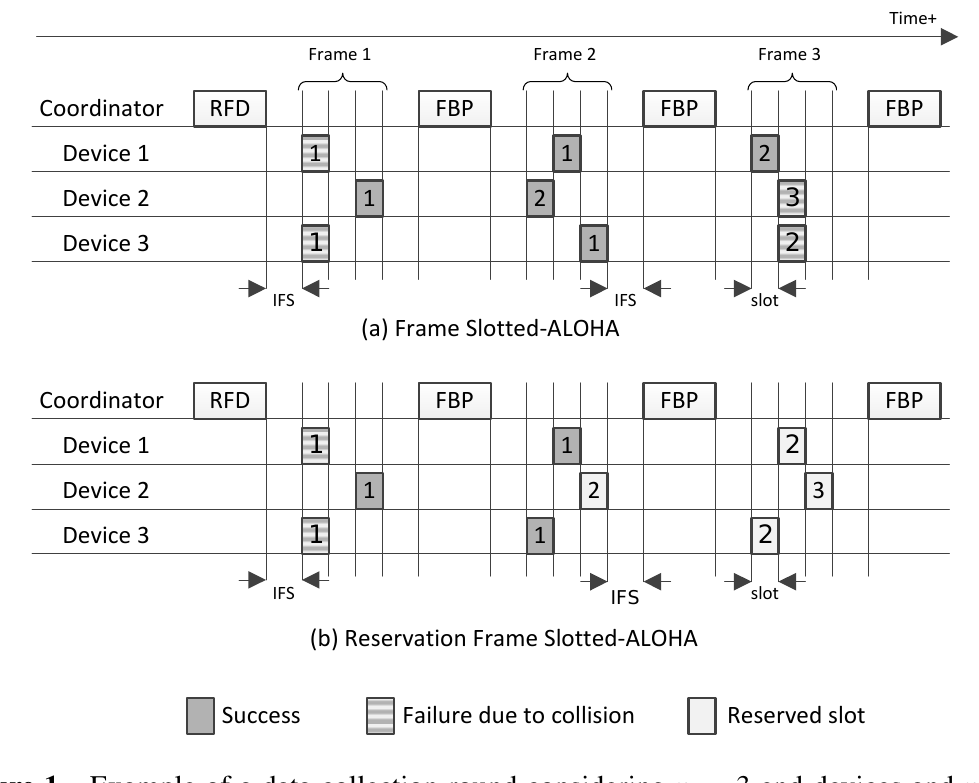
Figure 1. Example of a data collection round considering n = 3 end-devices and m = 3 slots per frame using: ( a ) frame slotted-ALOHA (FSA); and ( b ) reservation FSA (RFSA). The numbers inside the slots indicate the sequence number of the data packet transmitted by each